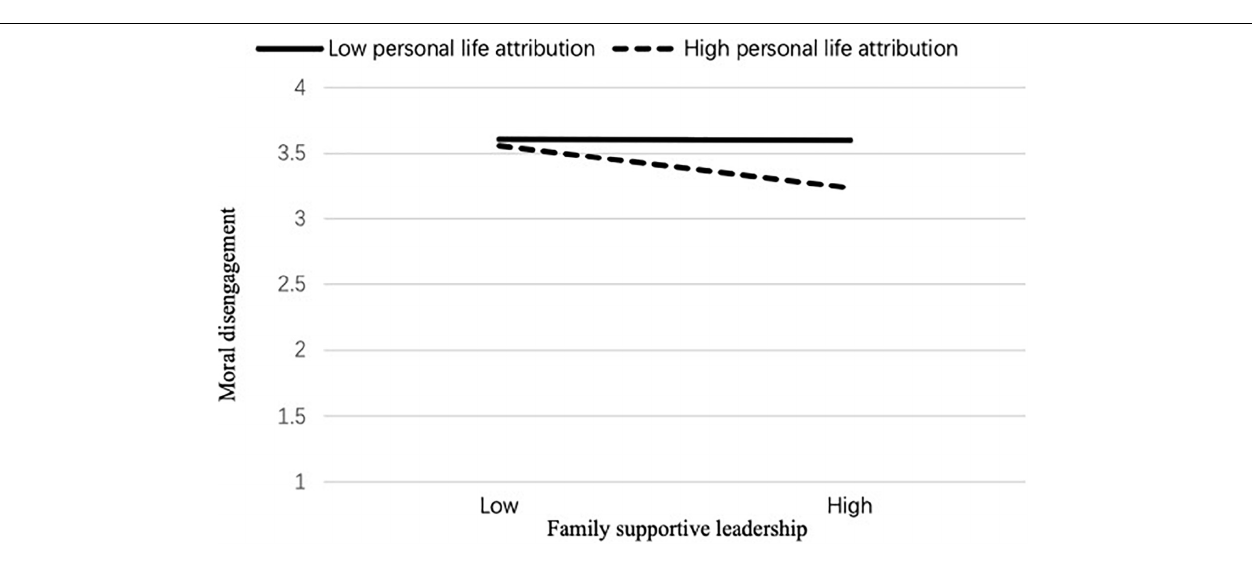
attribution ( B = –0.28, t = –6.34, p < 0.001) than those with